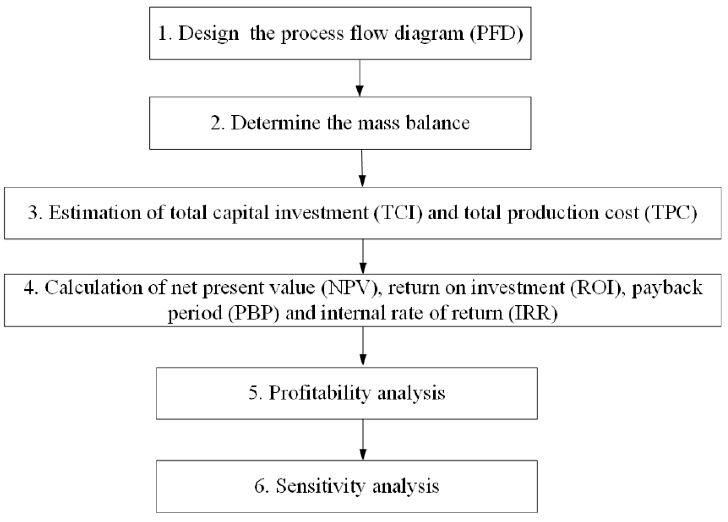
Figure 1. Methodology of techno-economic analysis.